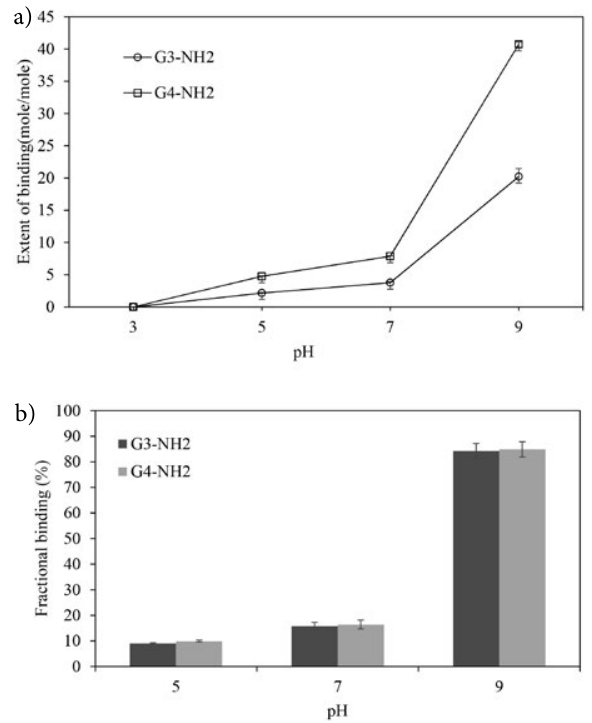
Figure 3. (a) EOB and (b) FB of total metal ions in aqueous solu- tions of JCPDs at room temperature as a function of